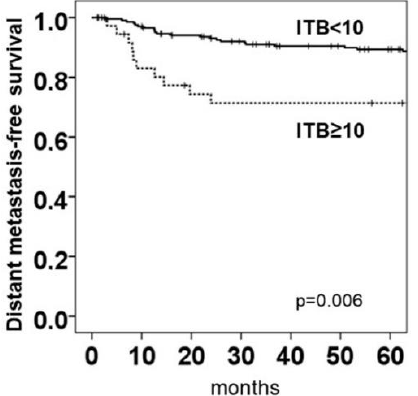
Figure 4. Kaplan–Meier analysis for NOS adenocarcinoma ( n = 245). Both primary pM1 patients (with local and distant R0 resection, n = 6) and primary pM0 patients developed secondary metastases ( n = 29). Prognostic significance of ITB score and distant metastasis-free survival. Log-rank test calculated with SPSS Version 26, IBM (Armonk, New York, NY, USA).